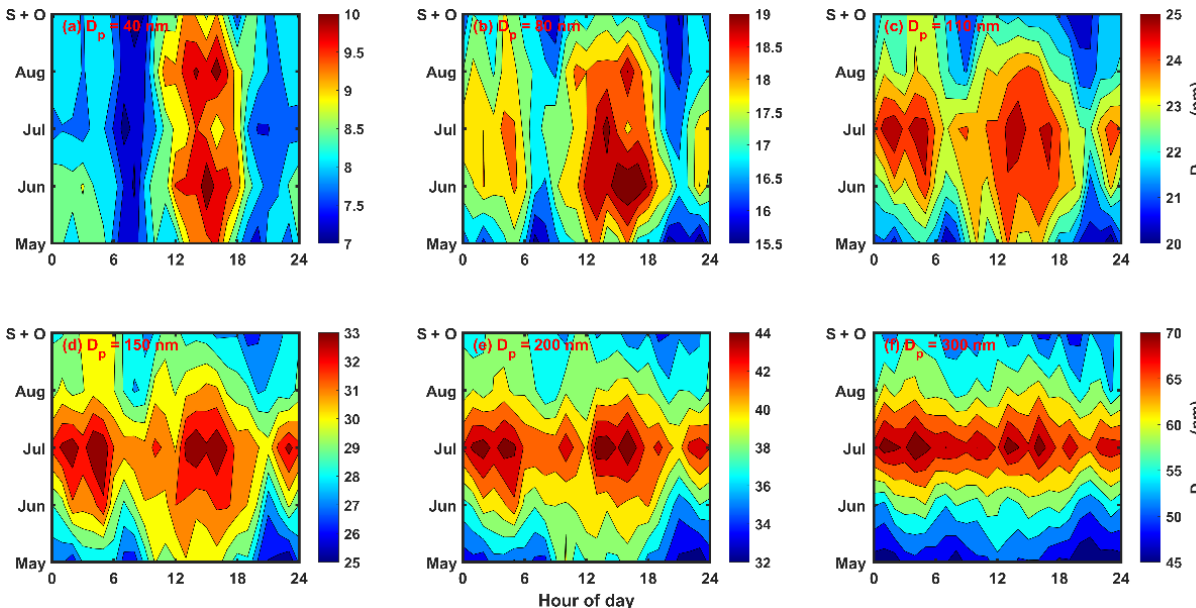
Figure 9. Diurnal variations in ensemble mean coating depth ( D c , mean ) on soot particles in different months for different particle sizes. Note that the color bars have different ranges of values in each